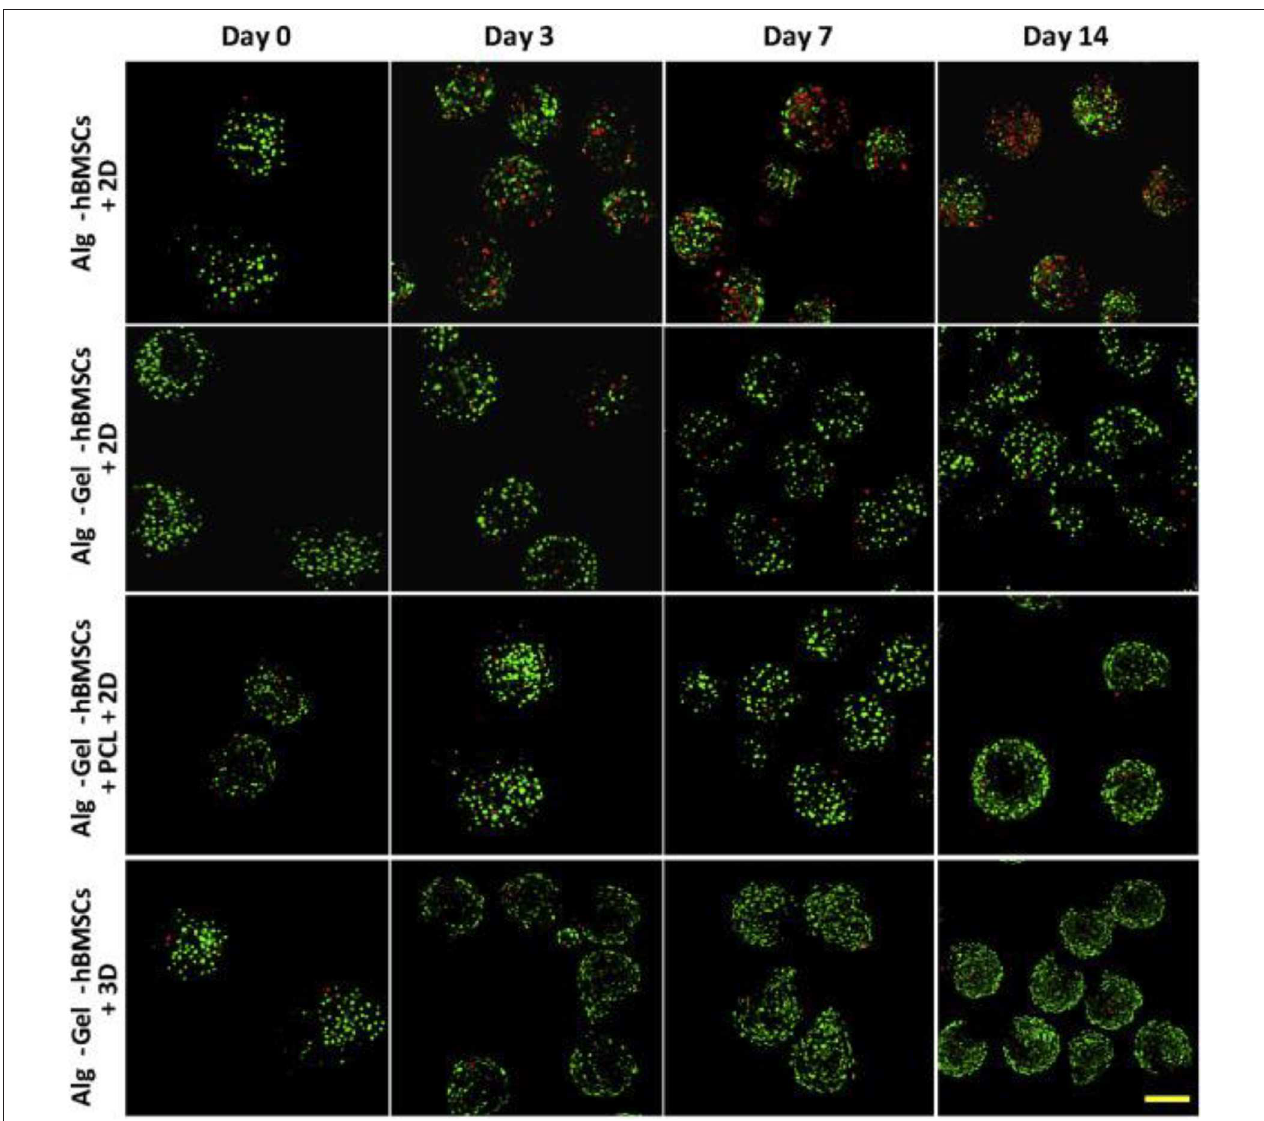
FIGURE 9 | Live/Dead staining of ALG-hBMSCs, ALG-Gel-hBMSCs, and ALG-Gel-hBMSCs/3D-printed PCL scaffold with 2D well plate culture and ALG-Gel-hBMSCs with 3D bioreactor culture on day 0, 3, 7, and 14, respectively. Scale bar = 200 µ m. Reproduced from Xu et al. (2019) with permission from Copyright 2019